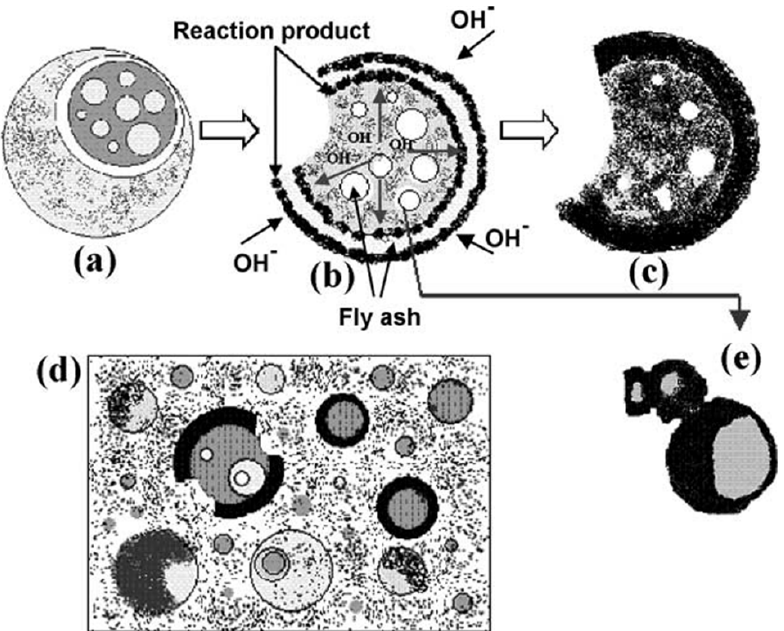
Figure 6. Descriptive model of the reaction process of fly ash: ( a ) initial chemical attack, ( b ) bi- directional alkaline attack, ( c ) reaction product, ( d ) several morphologies and ( e ) products covers certain portions [74].